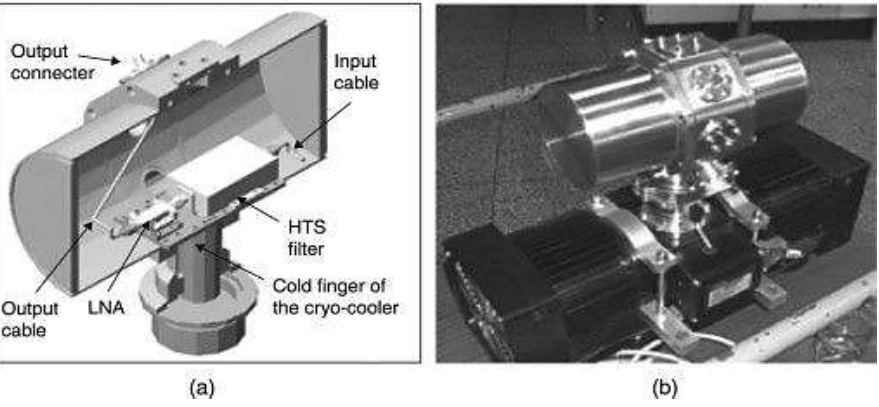
Figure 10: The HTS receiver's front-end microwave filter system, as sketched and photographed